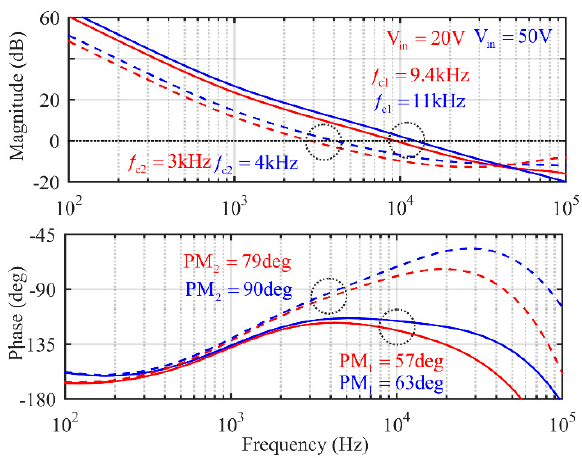
Figure 8. The output-voltage feedback-loop gains, when the PI controller with a high-frequency pole is used (solid lines) and when the PI controller without the high-frequency pole is used (dashed lines).